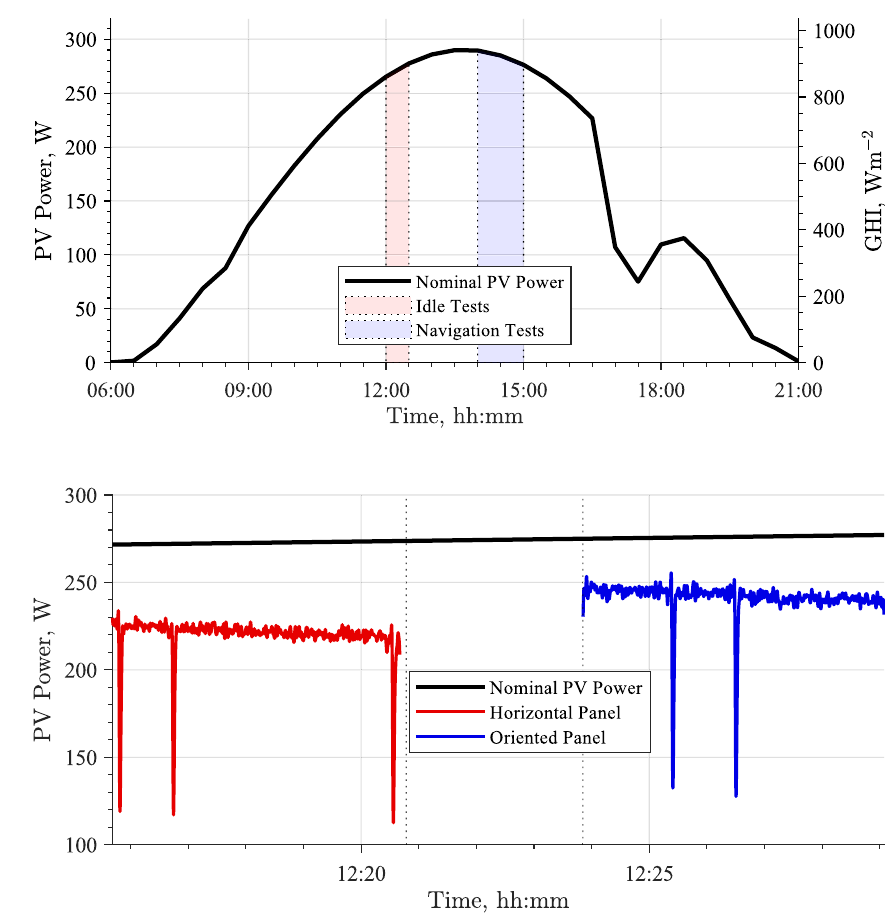
Fig. 8 Daily nominal solar power incident on the panels surface on May 12th 2021 in Torino, Italy, and test time frames